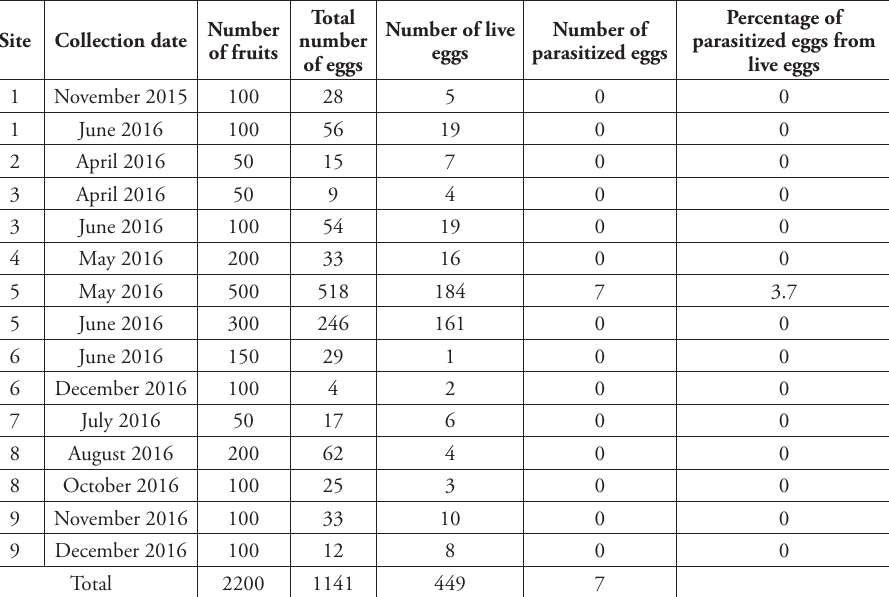
Table 2. Collection dates, and number of FCM eggs that were found in a field survey, in nine different locations in the Israeli central coastal